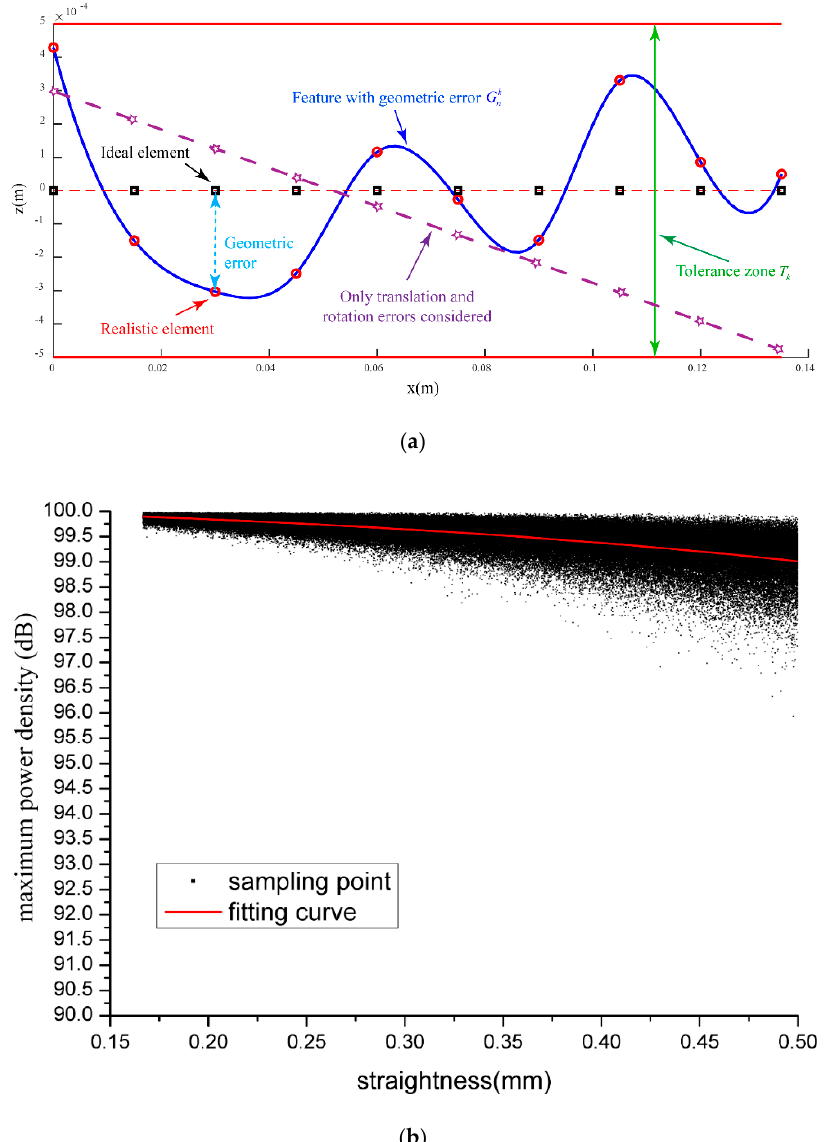
Figure 2. ( a ) The linear array. The black square dot represents the ideal element, and the red circular dot represents the realistic element with form error. The blue curve represents the realistic linear array while the red dotted line represents the ideal array. The purple dash line represents the linear array when only translation and rotation errors are considered. ( b ) The relation between the straightness and the maximum power density. For each sample of realistic geometric error of the linear array, the maximum power density was calculated based on Equation (A1), totally 10,000 samples were generated.